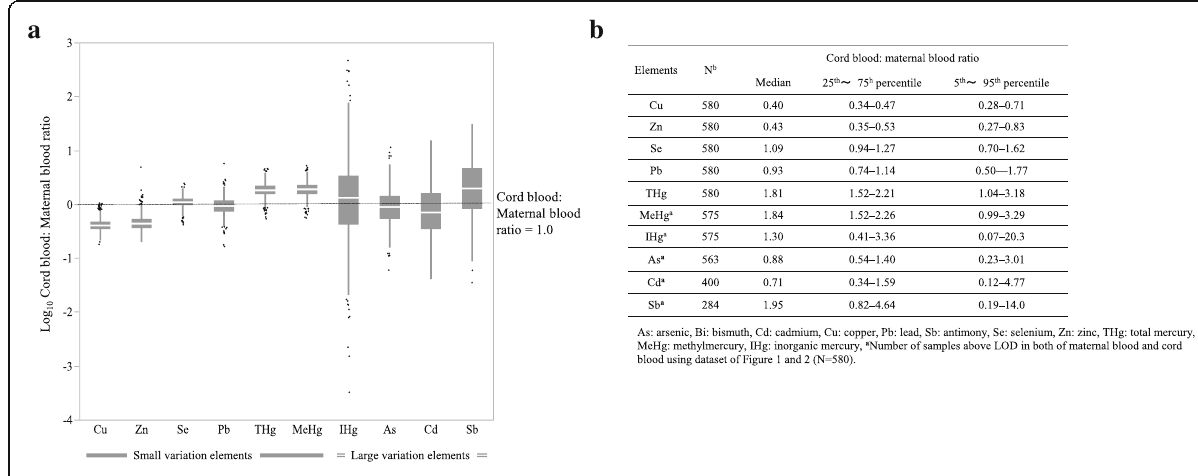
Fig. 3 Box-plot and table showing cord blood to maternal blood ratios of toxic and trace elements in the study population. a Cord blood to maternal blood ratios of Cu, Zn, Se, Pb, THg and MeHg were small variation and those of IHg, As, Cd and Sb elements were large variation. b Table shows cord blood to maternal blood ratios of each